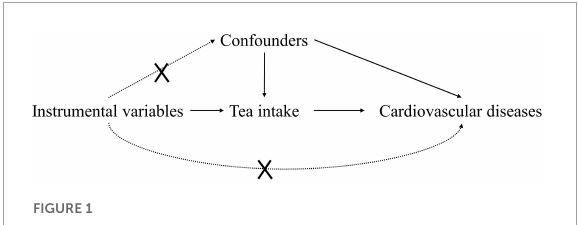
FIGURE1 Study design flowchart of the Mendelian randomization study.